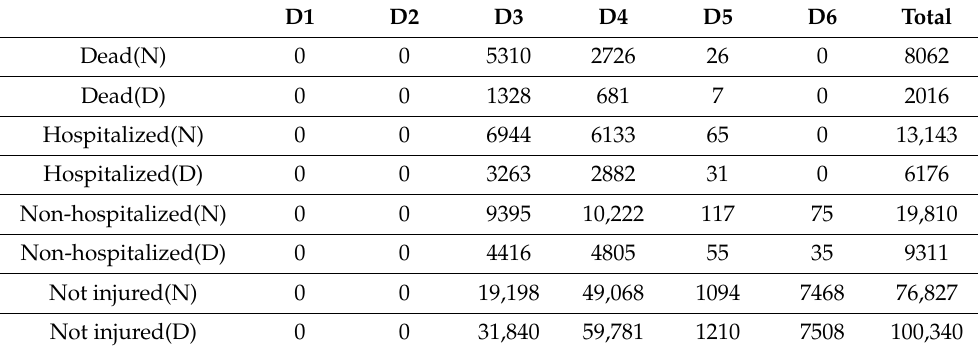
Table 26. Number of casualties in the 1780 earthquake in District 7 of Tabriz.